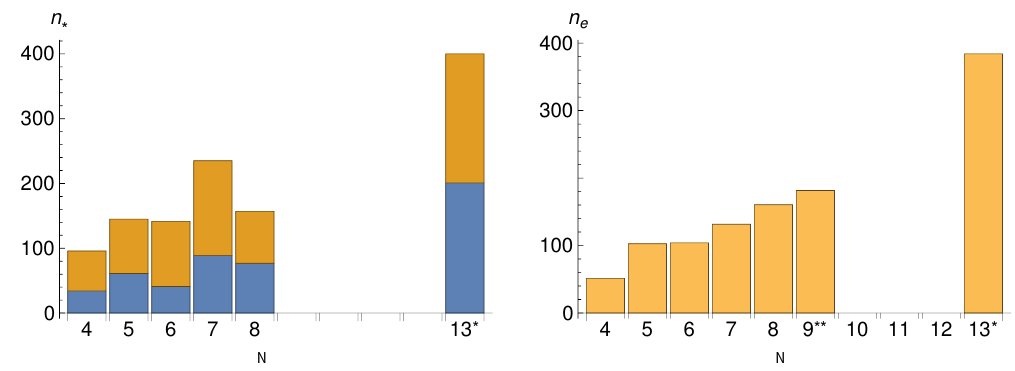
Figure 5 . On the left: a bar chart showing the mean required number of function calls to find (in blue) an allowed point and (in orange) the minimum of the navigator function for parameter spaces of various dimensions N . On the right: the mean number of function calls required to find the minimal or maximal allowed value for one of the navigator function parameters in a search space of dimension N . ∗ : note that in the case of the 13 dimensional optimization problems the gradient threshold termination condition was never fully reached. However, the step sizes have converged to steps smaller than O (10 − 7 ) . ∗∗ : the 9 parameter optimization is the optimization of the 13-parameter navigator restricted to a 9 dimensional subspace by fixing 4 parameters to fixed